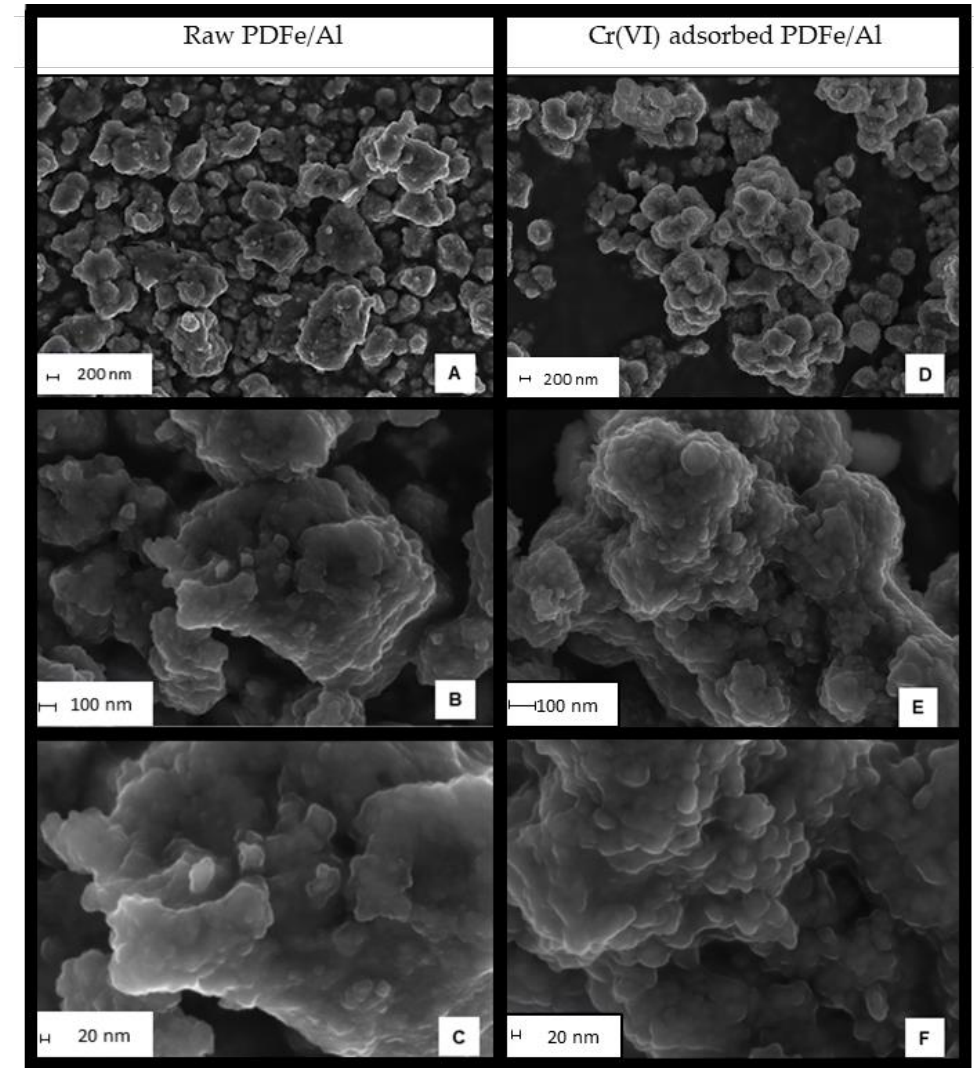
Figure 7. Morphology of the PDFe/Al before adsorption ( A – C ) and after Cr(VI) ( D – F ) adsorption. The morphological features of the synthesized PDFe/Al before and after Cr(VI) ad- sorption are presented in Figure 7. Figure 7A–C show the morphology of raw